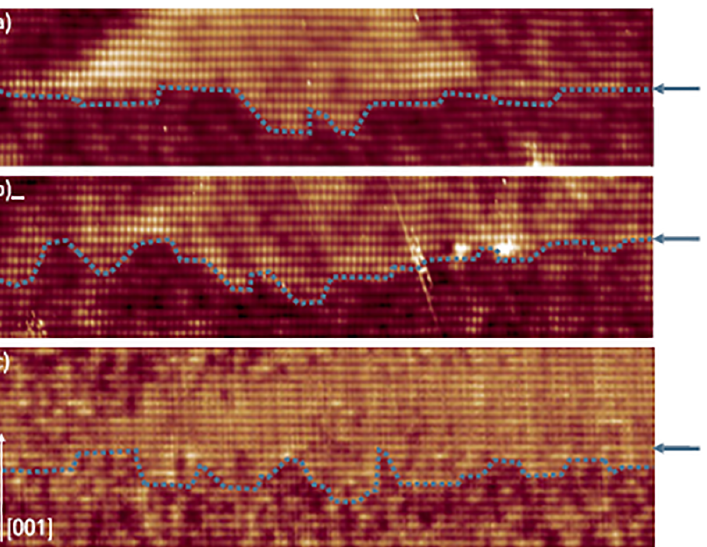
Figure 9. ( a , b ) 24 × 9 nm 2 , and ( c ) 35 × 13 nm 2 filled-state topography images of the bottom interfaces (indicated by dotted lines) of DE-QDs. GaAs inclusions are present below the QDs. Locally above those intrusions more Al atoms are incorporated inside the QD. The arrow indicates the growth direction [001]. Adopted from Ref.